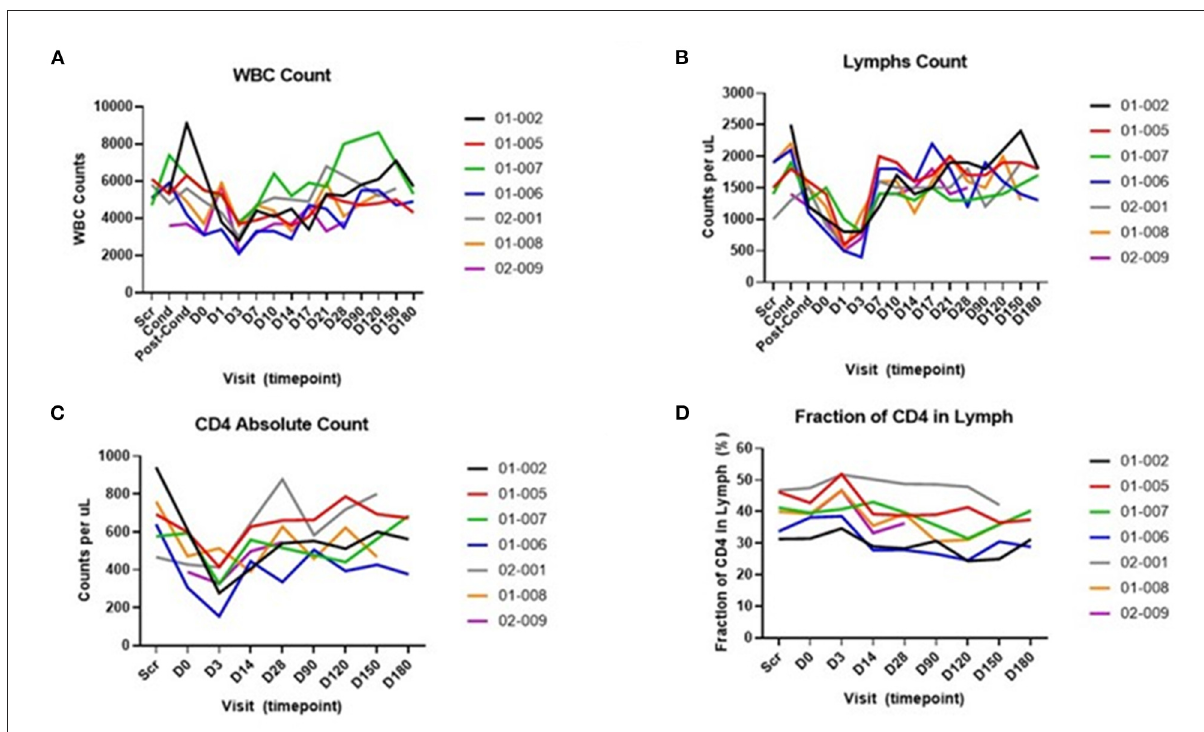
FIGURE2 Hematology studies during participant monitoring. (A) White blood cell (WBC) counts expressed as counts per microliter ( µ L). (B) Lymphocyte (lymphs) counts expressed as counts per microliter ( µ L). (C) Absolute CD4T cells, expressed as counts per microliter ( µ L). (D) Fraction of CD4T cells in lymphocytes, expressed as a percentage (%). Scr, screening; cond, cyclophosphamide conditioning; post-cond, post-conditioning, D0 indicates the day of infusion; D1, D3, etc., indicate days after infusion. Individual trial participants are indicated by a 5-digit identifier in the legend.